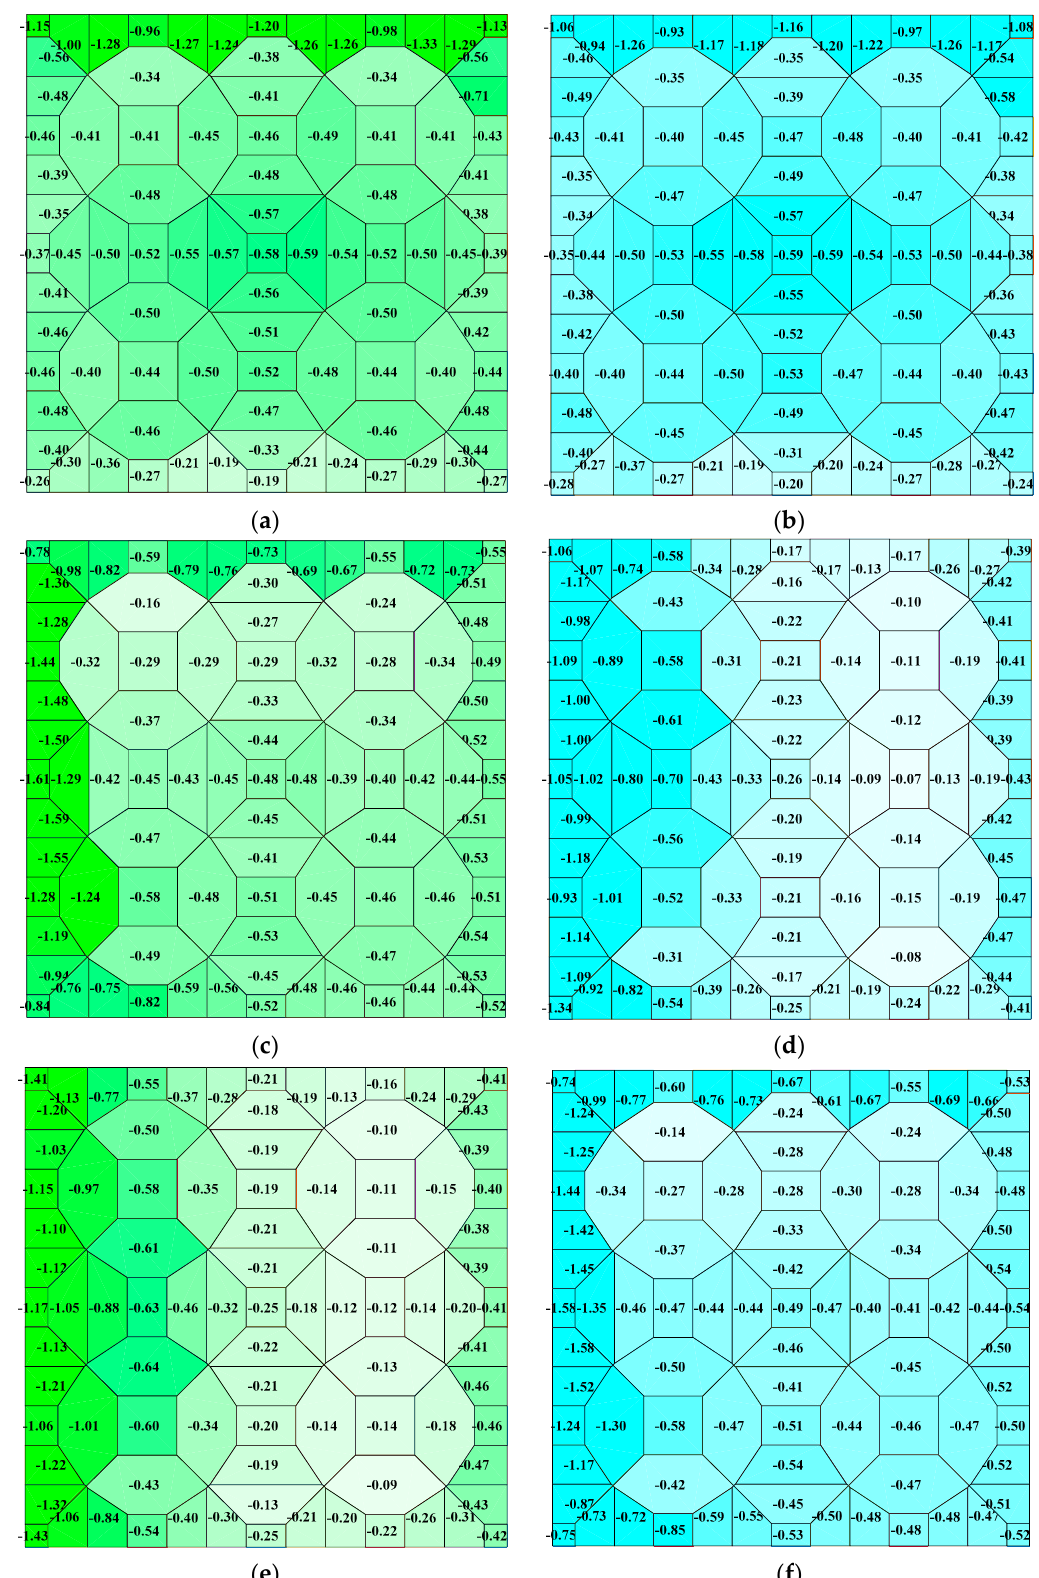
Figure 7. Model 1, mean pressure coefficient maps for α = 0° ( a ), α = 45° ( c ), and α = 90° ( e ); maps using mode of pressure coefficients for α = 0° ( b ), α = 45° ( d ), and α = 90° ( f ).